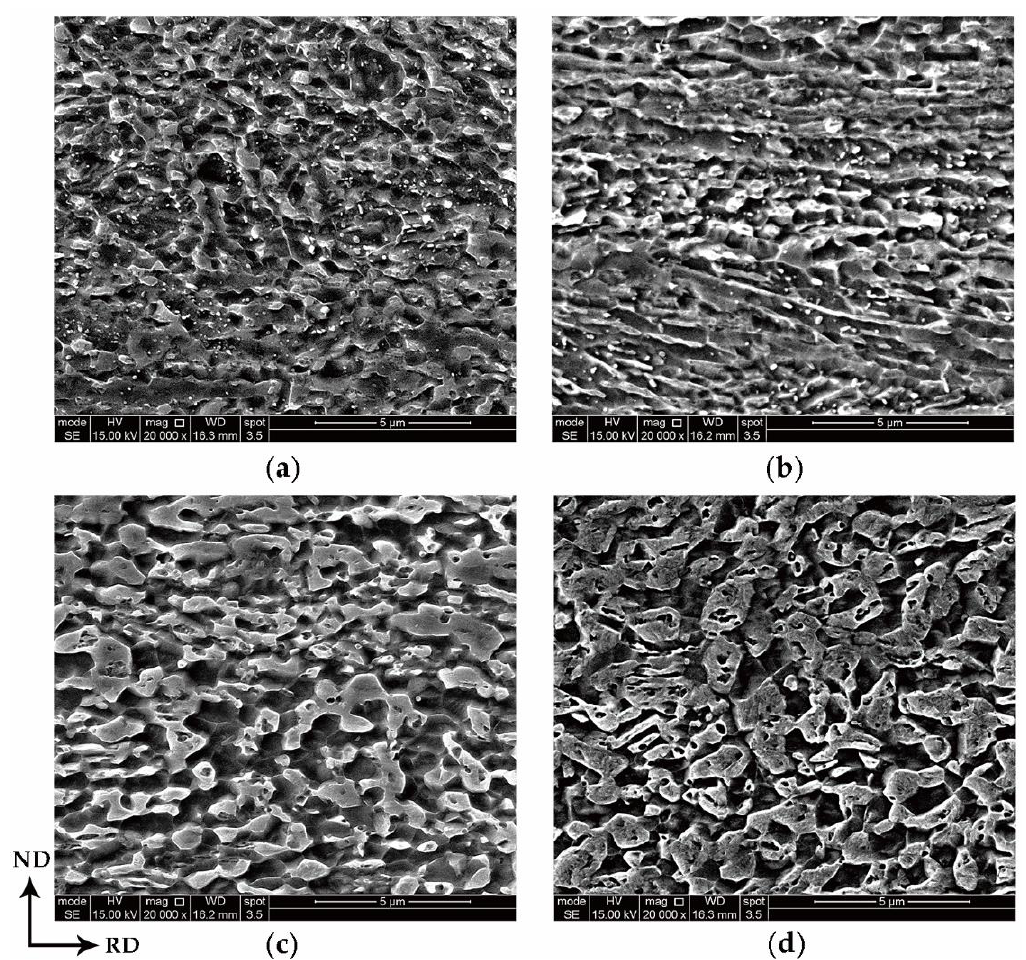
Figure 4. Microstructure of the samples: ( a ) A650, ( b ) A675, ( c ) A700 and ( d ) A725.